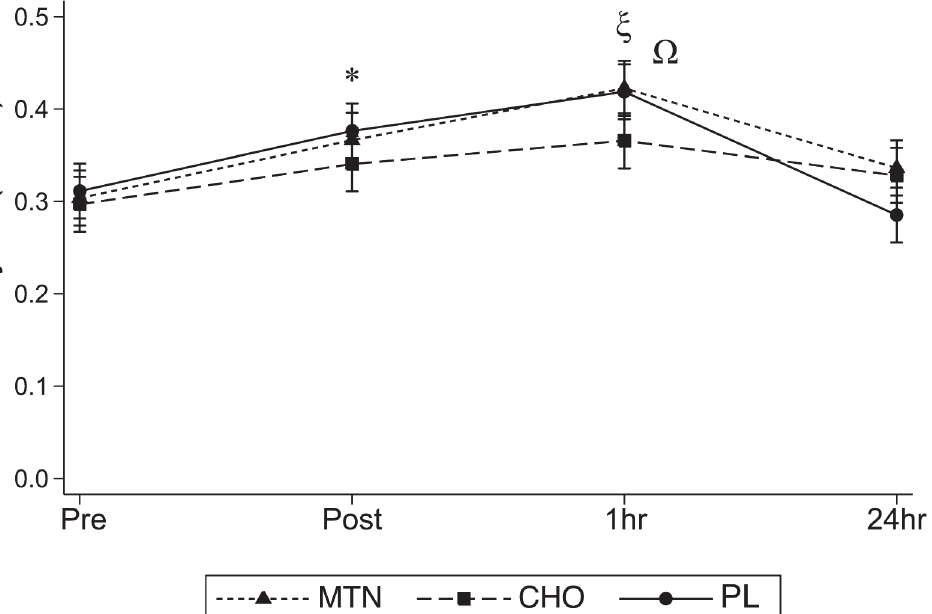
Fig 5. Monocytes counts determined at all times points for the three tested conditions. * p < 0.05 from post to pre for MTN and PL ξ < 0.05 from 1h to pre for all three conditions (MTN, CHO and placebo); Ω < 0.05 at 1h after exercise from MTN and placebo to